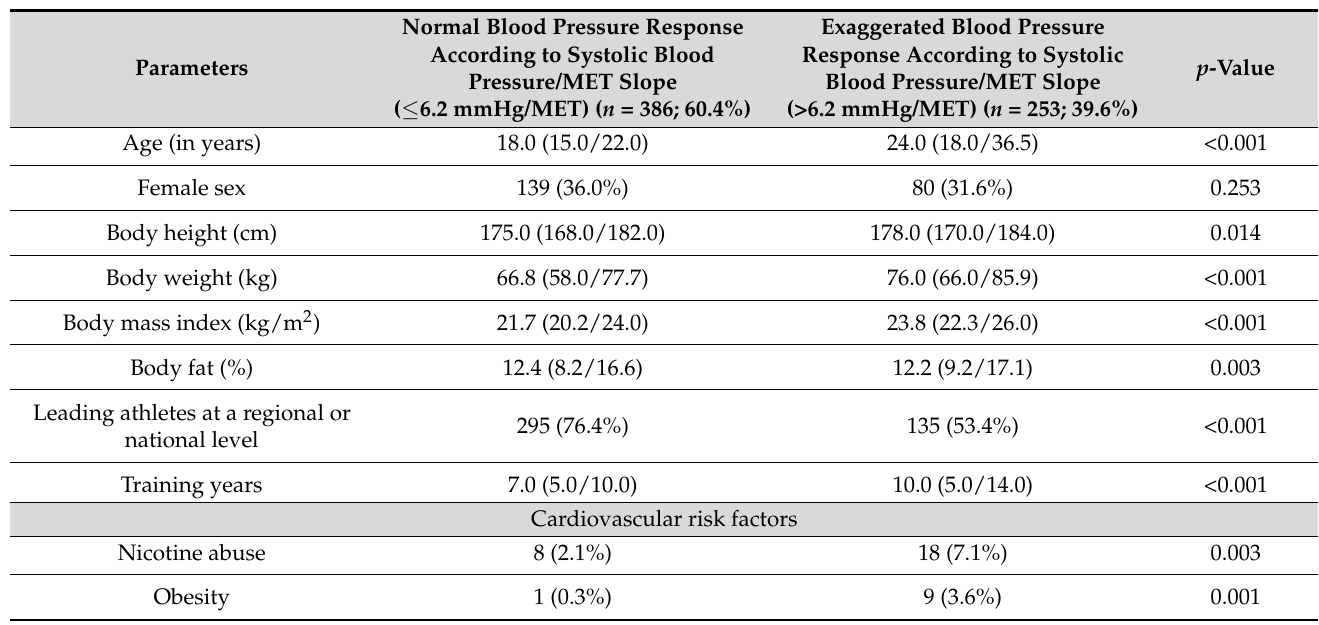
Table 5. Patient characteristics of the 639 examined athletes with spiroergometry and without known arterial hypertension stratified for exaggerated blood pressure response according to systolic blood pressure/MET